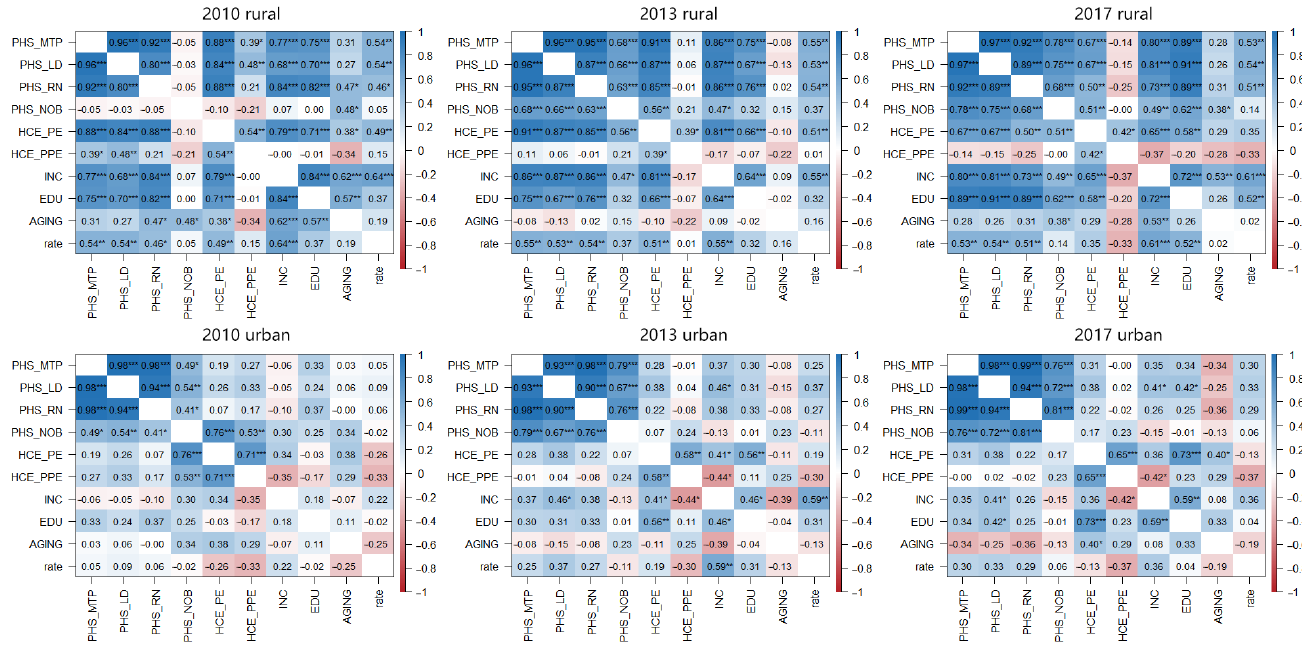
Figure 2. The comparison of urban and rural social environments.